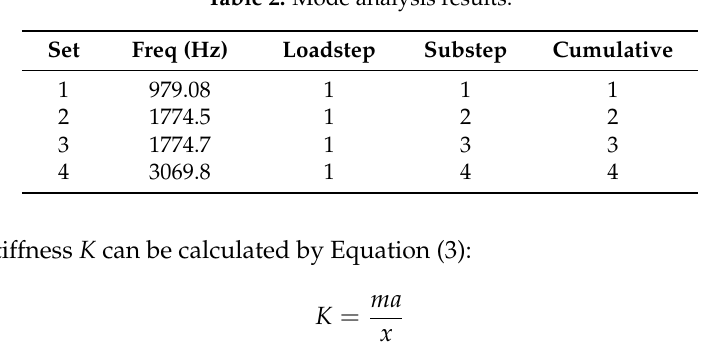
Figure 5. Modal graph of the vacuum microelectronic accelerometer. ( a ) The first mode, ( b ) the second mode, ( c ) the third mode, and ( d ) the fourth mode. Table 2. Mode analysis results.